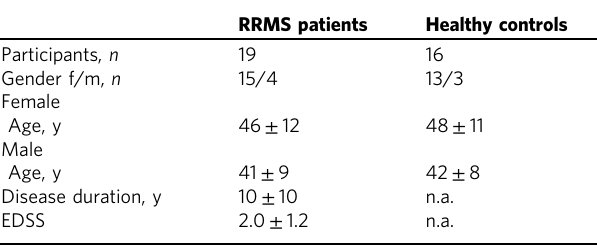
Table 1 Demographics of patients with multiple sclerosis and healthy